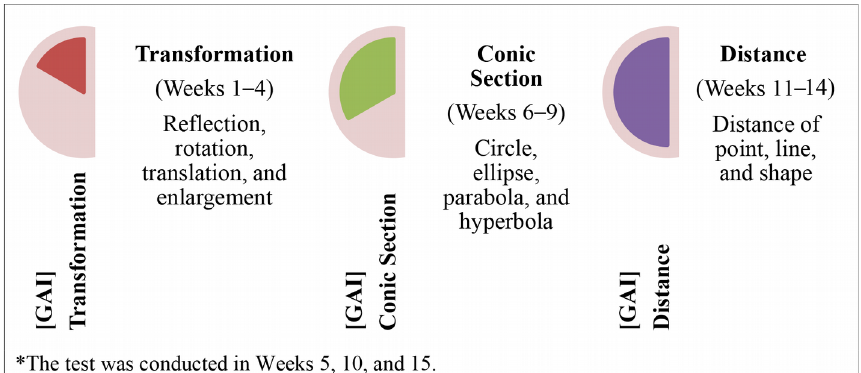
Figure 3. Schedule of model and non-model